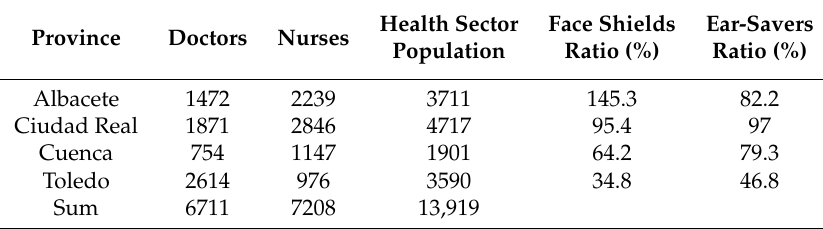
Table 8. Health sector and PPE 3D printed